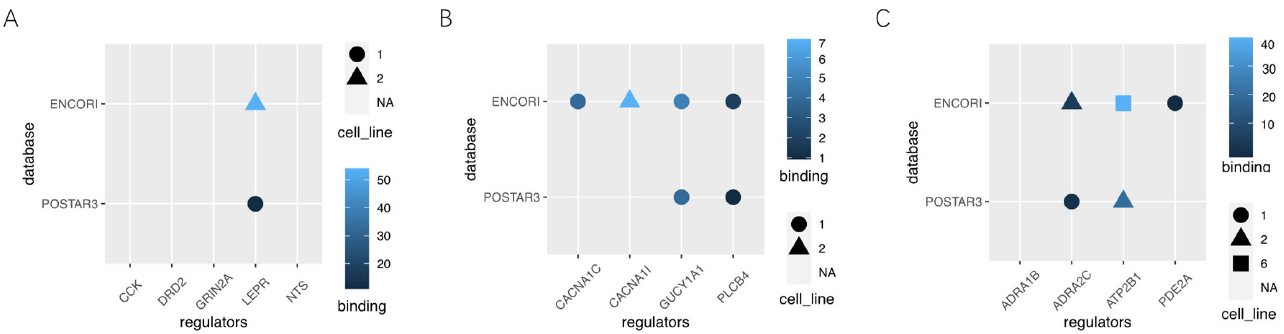
Figure 7. ( A – C ) The effects of IGF2BP1 on the differentially expressed genes of neuroactive ligand– receptor interaction, circadian entrainment, and cGMP-PKG signal pathway.